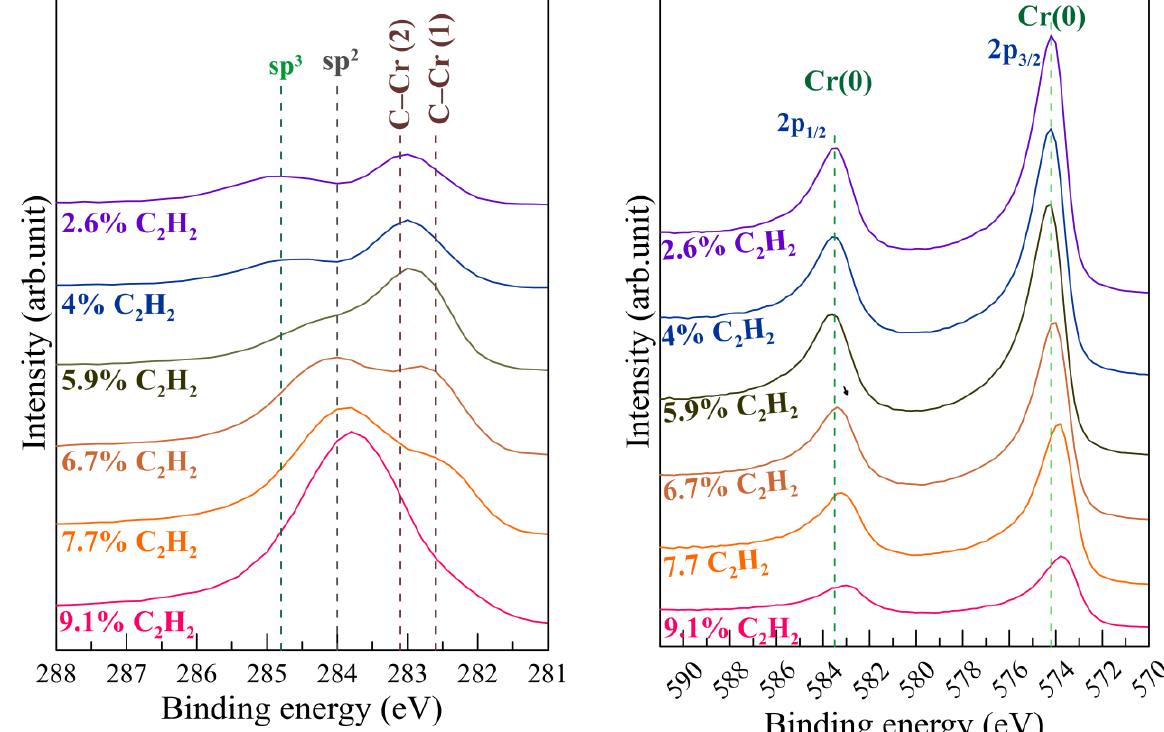
Figure 4. The ESCA (XPS) C1s ( left ) and Cr2p ( right ) spectra of Cr–C films deposited on the Si (100) substrate with a substrate bias of − 150 V at 0.8 Pa deposition atmosphere with different C 2 H 2 gas fractions.